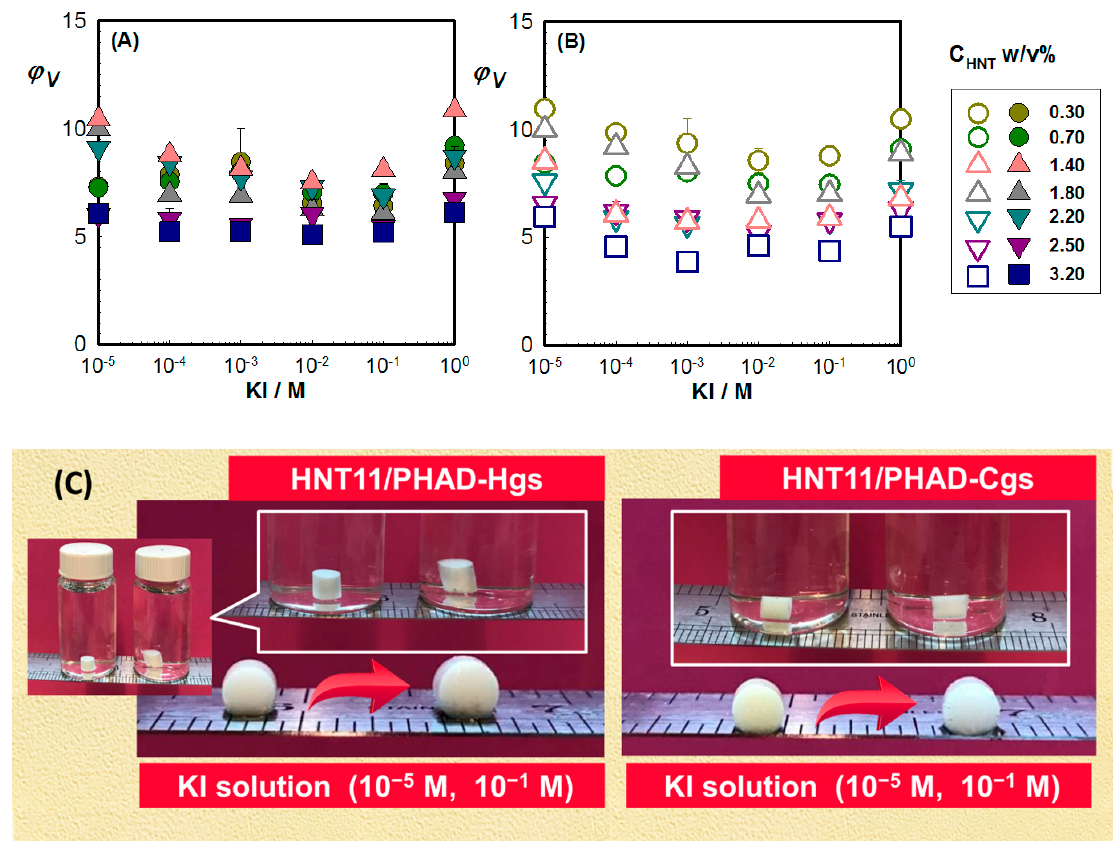
Figure 11. The equilibrium volume swelling ratio ϕ V of HNTm/PHAD-Hgs ( A ) and HNTm/PHAD-Cgs ( B ) as a function of the ionic strength of aqueous salt solutions of KI. Photographs of HNT11/PHAD-Hgs and -Cgs containing 3.20% ( w/v ) HNTs after their swelling in 10 − 5 M and 10 − 1 M KI solutions ( C ).